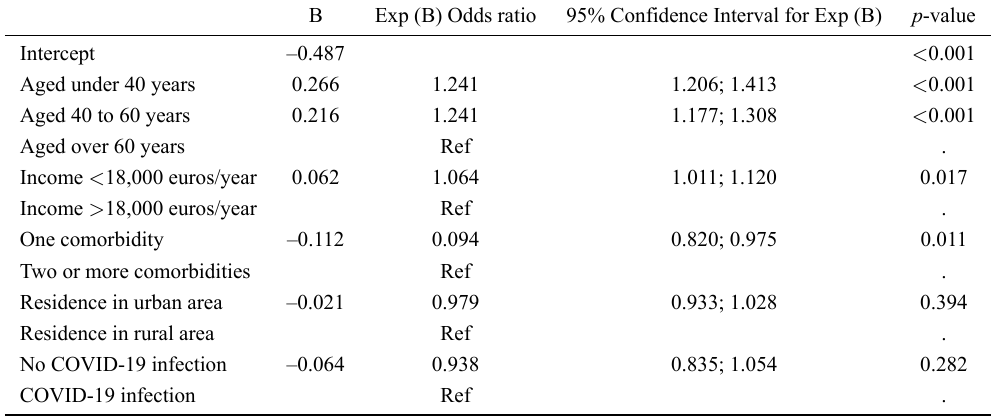
Table 4. Multivariable logistic regression of factors associated with a deterioration of depression and